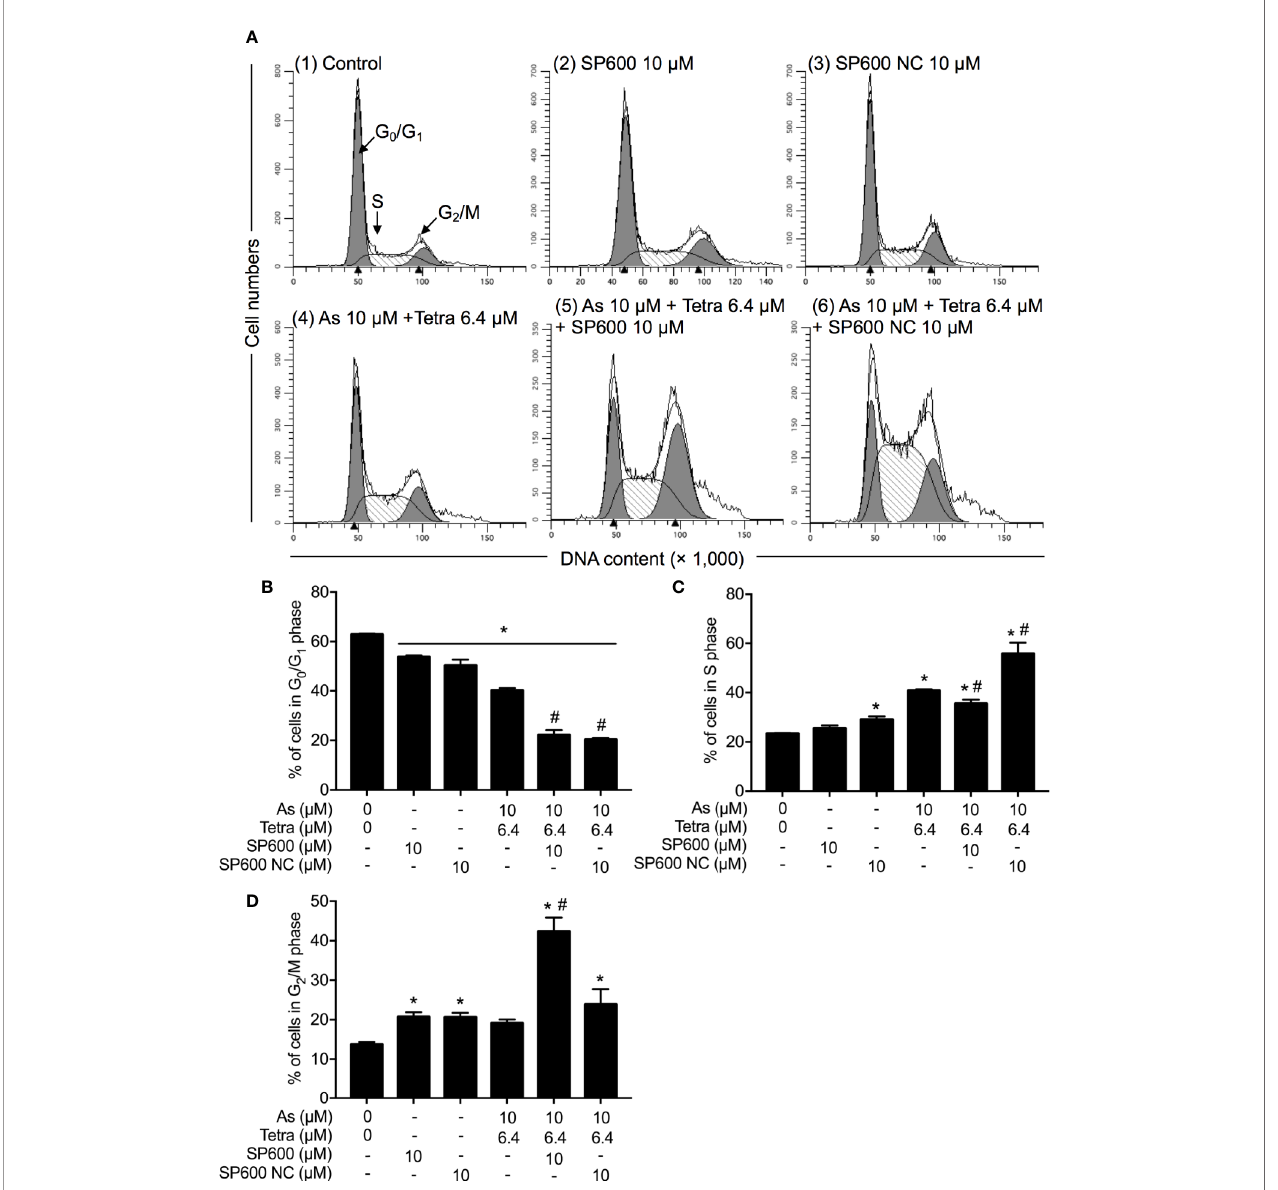
FIGURE 10 | Association of JNK activation with cell cycle progression of MDA-MB-231 cells treated with As III in combination with Tetra. (A – D) After treatment with 10 m M As III +6.4 m M Tetra in the presence or absence of 10 m M of SP600125 or its negative control SP600125NC for 48 h, cell cycle pro fi ling was performed by FACSCanto fl ow cytometer. Analyzed data and pro fi les for each G 0 /G 1 and G 2 /M phase using Diva software and ModFit LT ™ ver.3.0. are shown in the gray area. Cells at S phase are shown as shaded area. A representative FACS histogram from three separate experiments is shown (A) . *p<0.05, vs. control; # p<0.05, vs. 10 m M As III +Tetra 6.4 m M. As, As III ; Tetra, tetrandrine; SP600, SP600125; SP600 NC,